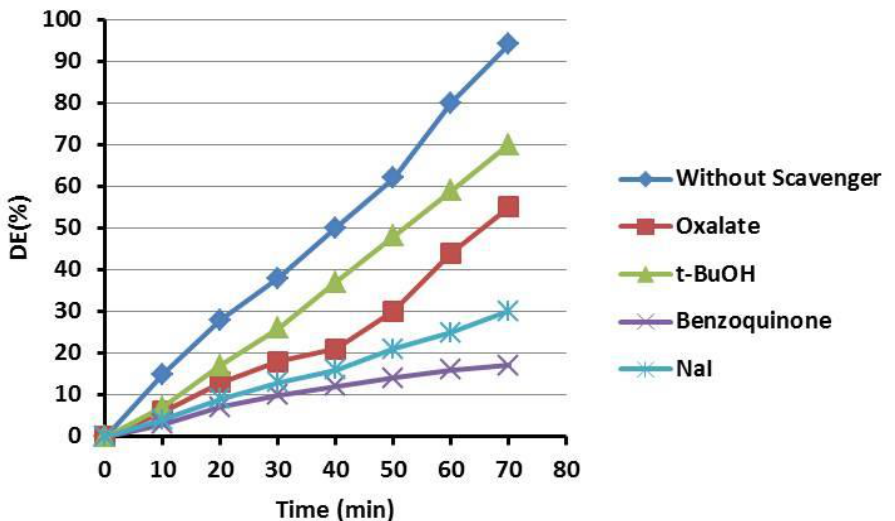
Figure 9. The effects of various scavengers on decolorizing of Reactive Blue 19, [Dye] = 20 mg/L, [Catalyst] = 1.25 g/L, pH= 6.5, [Scavenger] = 5 mM